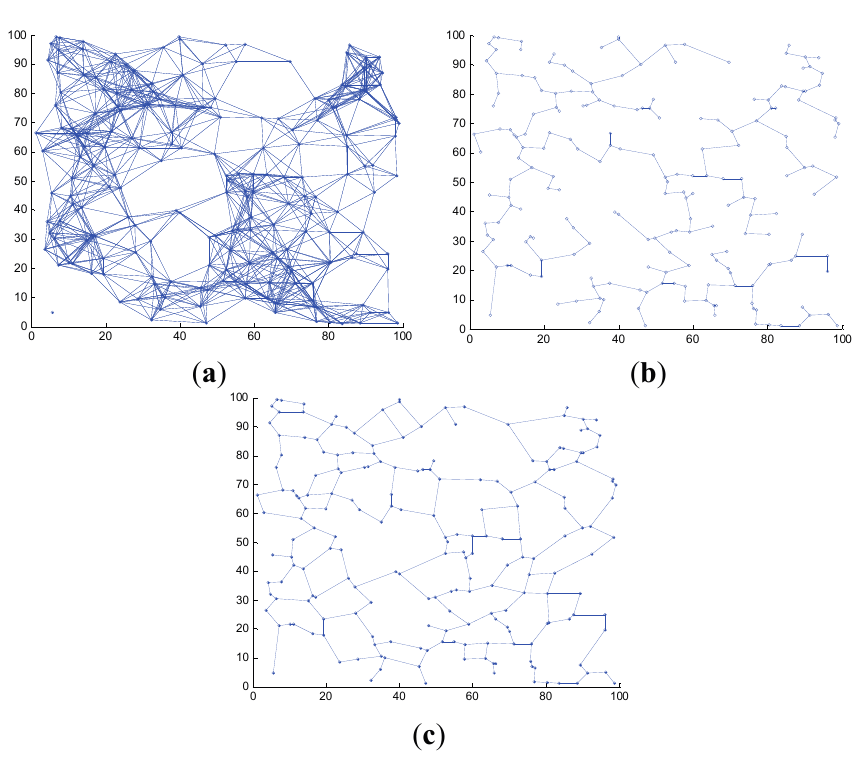
Figure 2. Comparison of ( a ) The full graph (cid:1833) ; ( b ) MST of (cid:1833) ; ( c ) RNG of (cid:1833) .